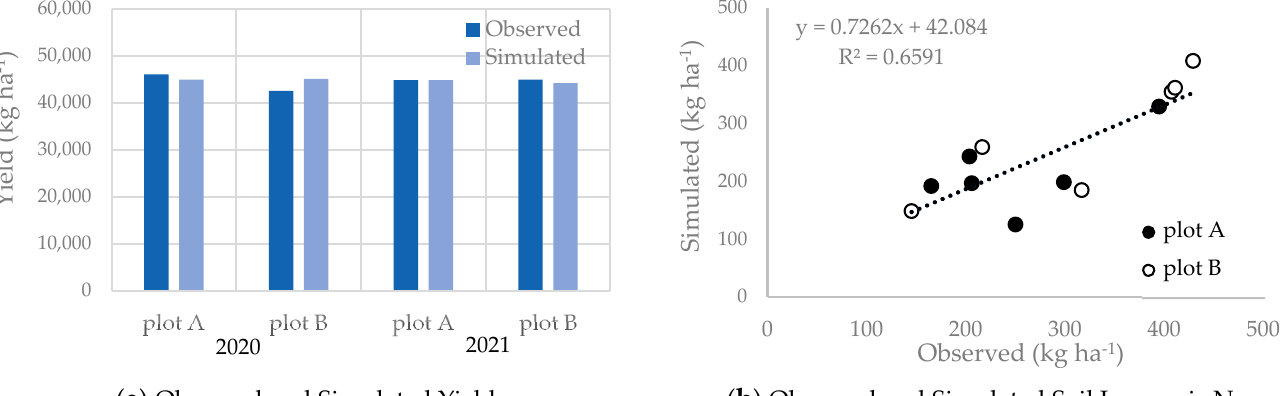
Figure 3. ( a ) Observed and simulated yield (kg ha − 1 ) for the two plots (A and B) in 2020 and 2021; ( b ) comparison of observed and simulated soil inorganic N (sum of NH 4 -N and NO 3 -N) within the 0–90 cm depths in 2020 and 2021. Table 5. Statistical comparison between the observed and simulated yield and soil inorganic N (sum of NH 4 -N and NO 3 -N) within the 0–90 cm depths in 2020 and 2021. Evaluated